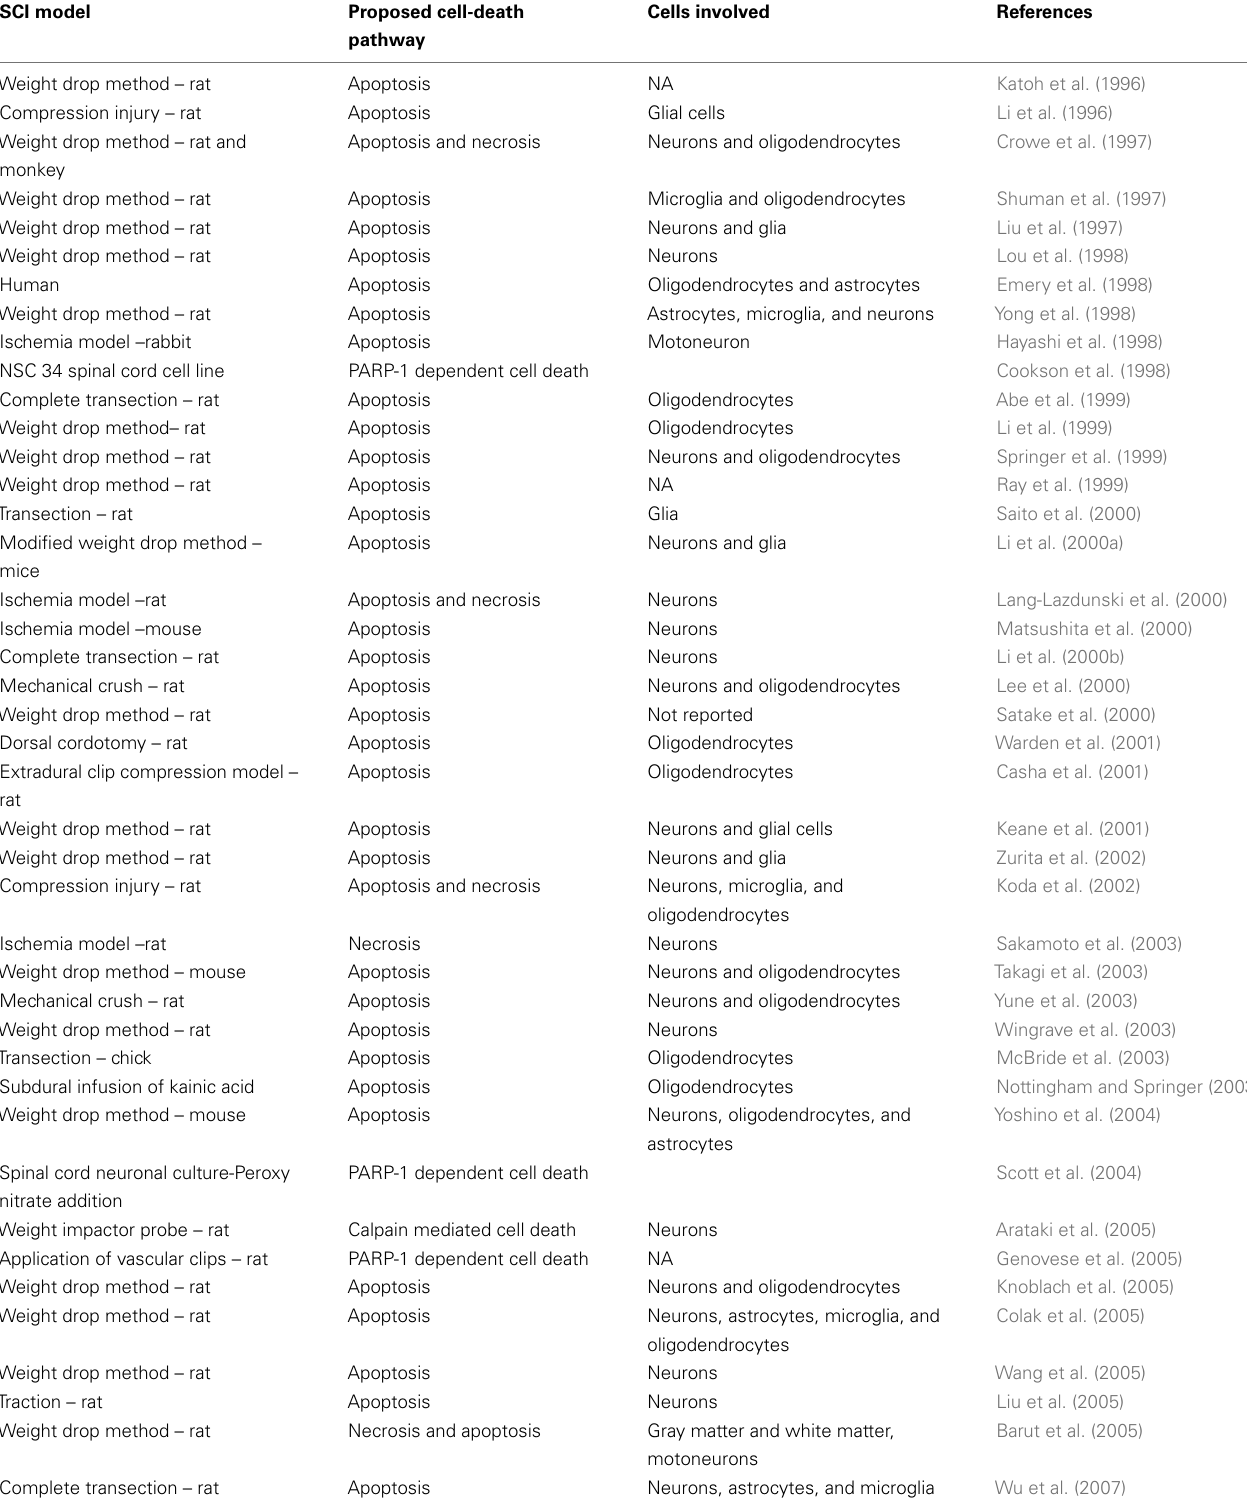
TableA1 | Characteristics of cell damage of in vivo and in vitro models of spinal